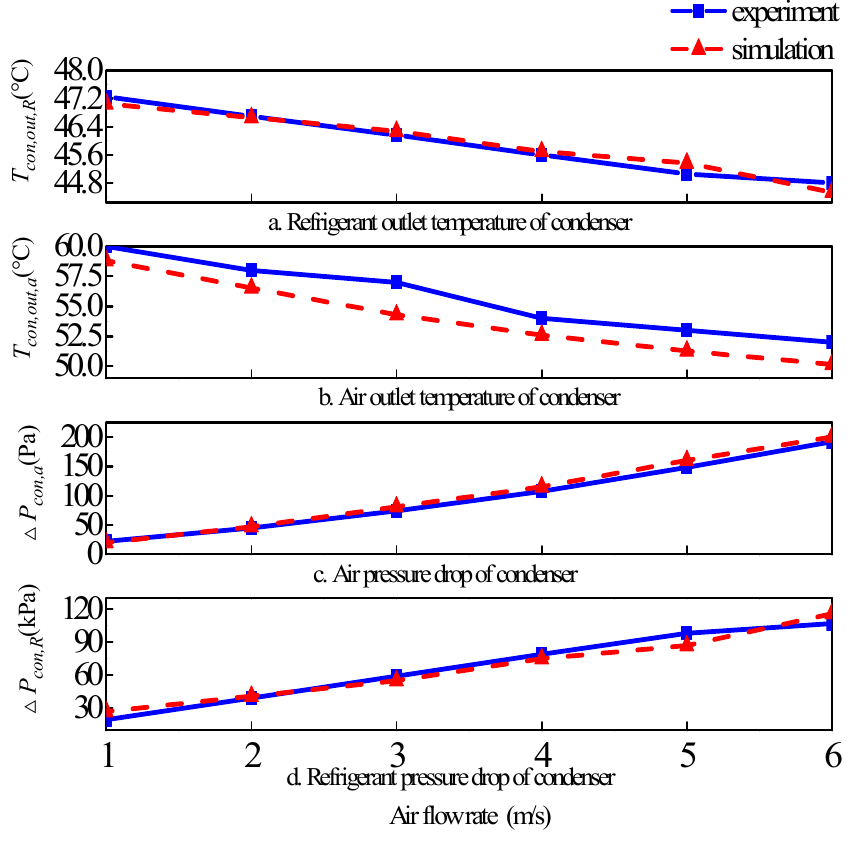
Figure 13. Pressure and temperature comparison in the condenser.